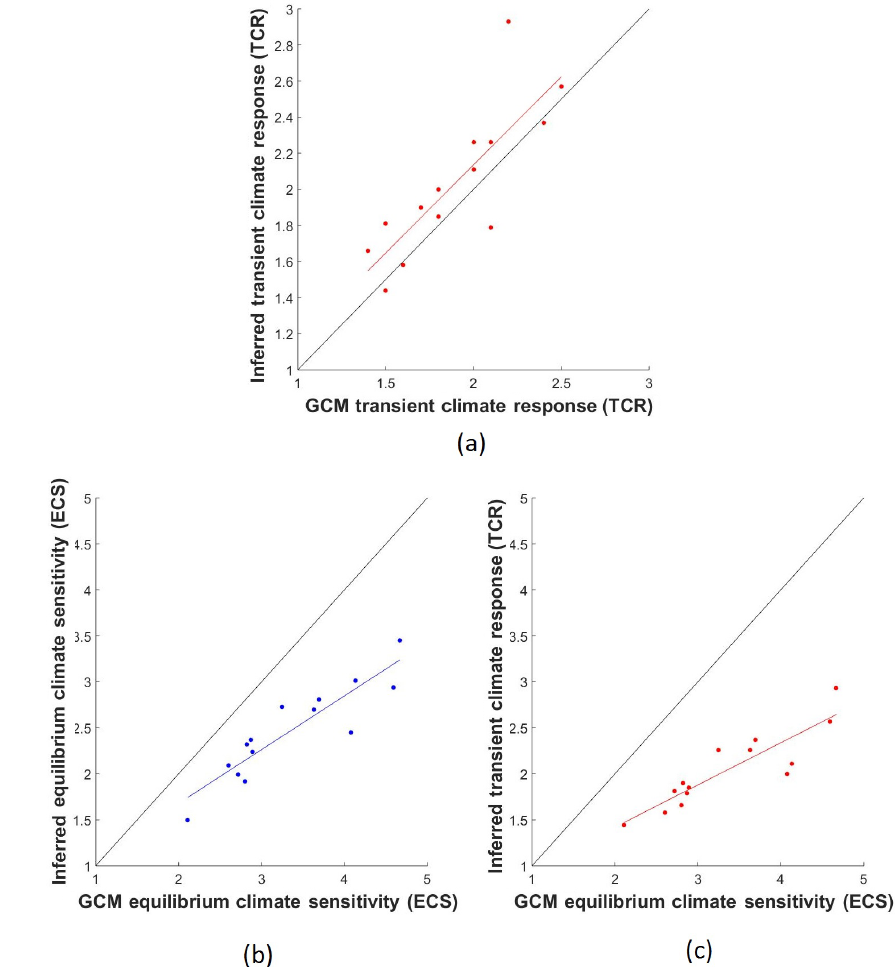
Figure 7. Inferred effective TCR (K) vs. AOGCMs’ TCR (K) (a) , inferred effective ECS (K) vs. AOGCMs’ ECS (K) (b) , and inferred effective TCR (K) vs. AOGCMs’ ECS (K) (c) . While the TCRs differ by less than 0.2K, the ECSs differ by up to 2K. This opens the door for a discussion as to whether PH99 should be calibrated using scenario-class-adjusted effectively lower ECS